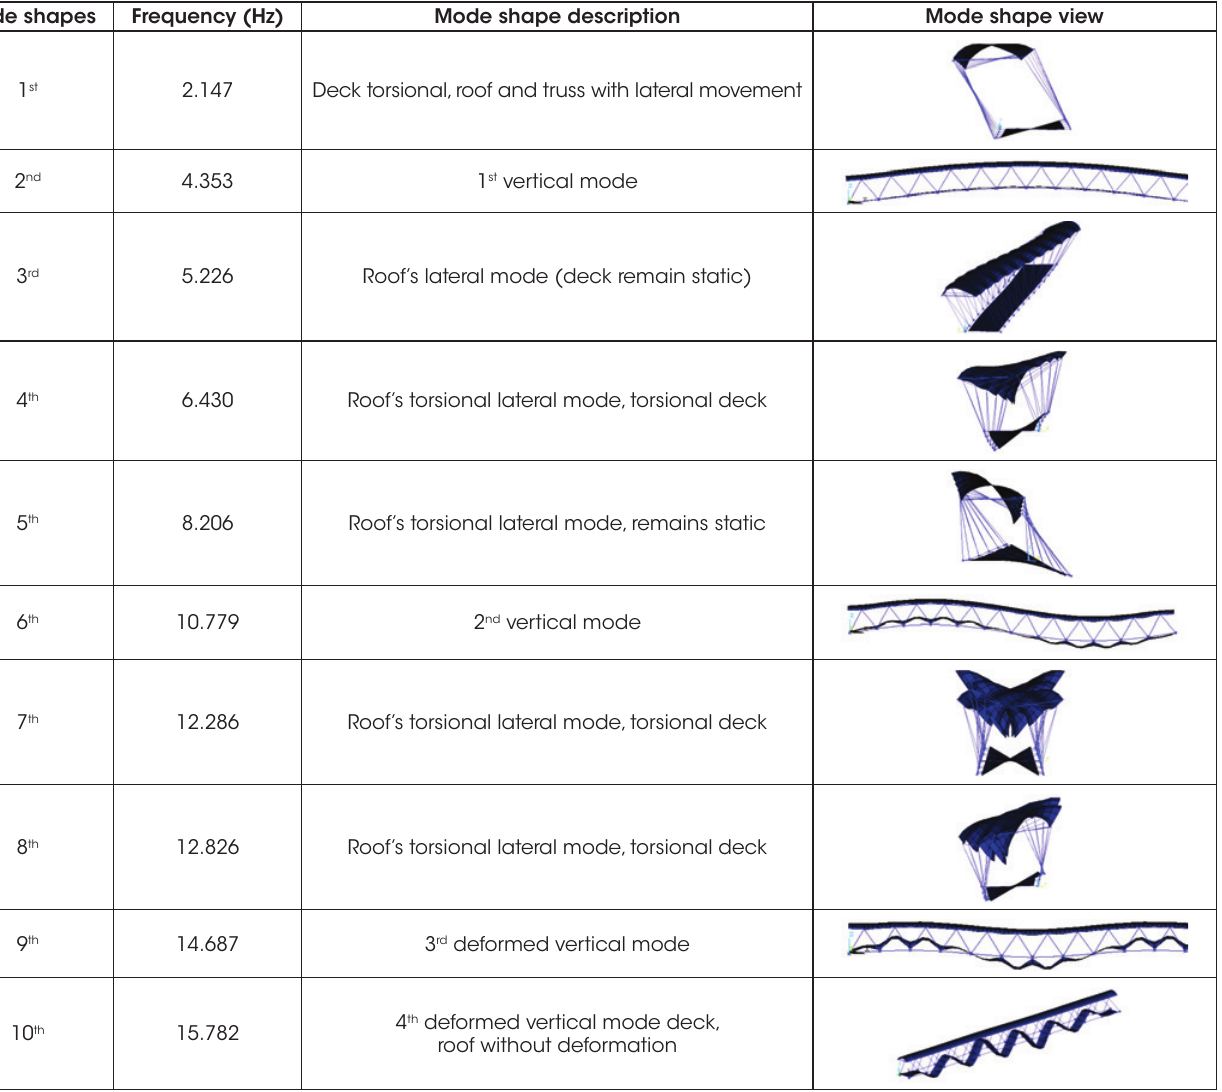
Analysis of free vibrations of the footbridge on E.P.I.A. ( Estrada Parque Indústria e Abastecimento ) – Model 1 Mode shapes Frequency (Hz) Mode shape description Mode shape